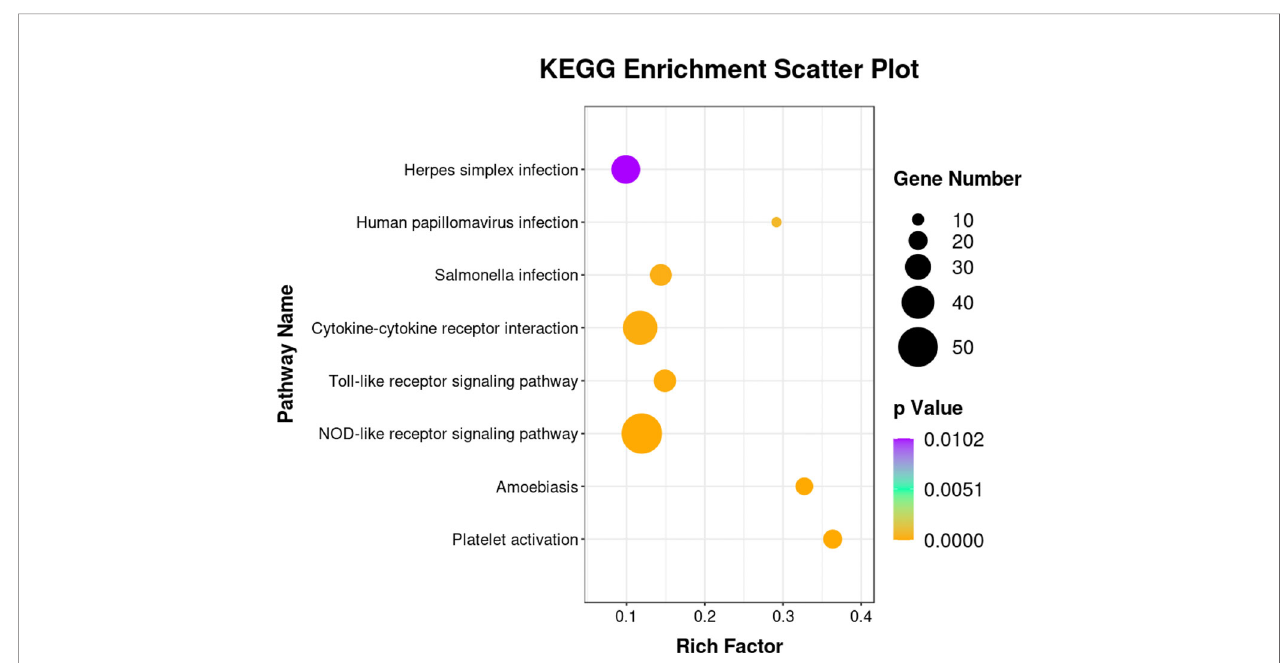
FIGURE 7 | Kyoto Encyclopedia of Genes and Genomes (KEGG) enrichment analysis of immune-associated pathways showing signi fi cant differences between control and 16-h transport group.